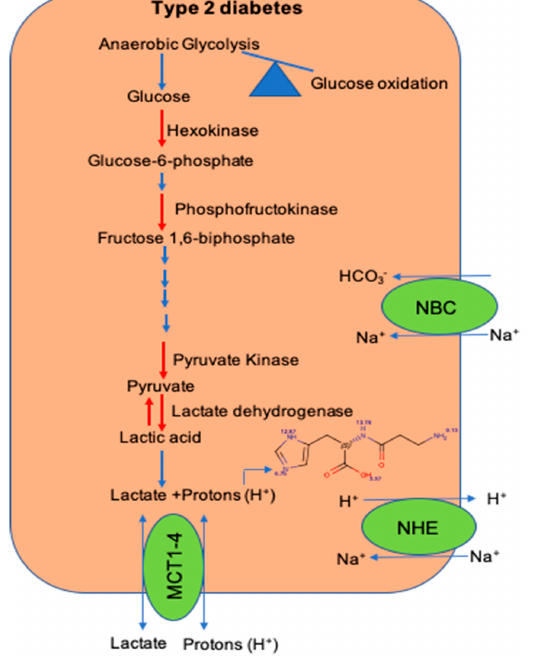
Figure 2. Shift in glucose utilization and imbalance of pathways that maintain intracellular pH during diet-induced metabolic syndrome. A shift in glucose utilization from glucose oxidation to anaerobic glycolysis enhances lactate production and hydrogen (H + ) ions. Within the skeletal muscle, the activity of key glycolytic enzymes hexokinase and pyruvate kinase is decreased during metabolic syndrome. Expression of transporters; the Na-H + (NHE) exchanger, which transports hydrogen (H + ) ions during exercise and rest, respectively; and levels of histidyl dipeptides, which buffer H + ions, are decreased during diet-induced metabolic syndrome. Na + -dependent and independent bicarbonate systems